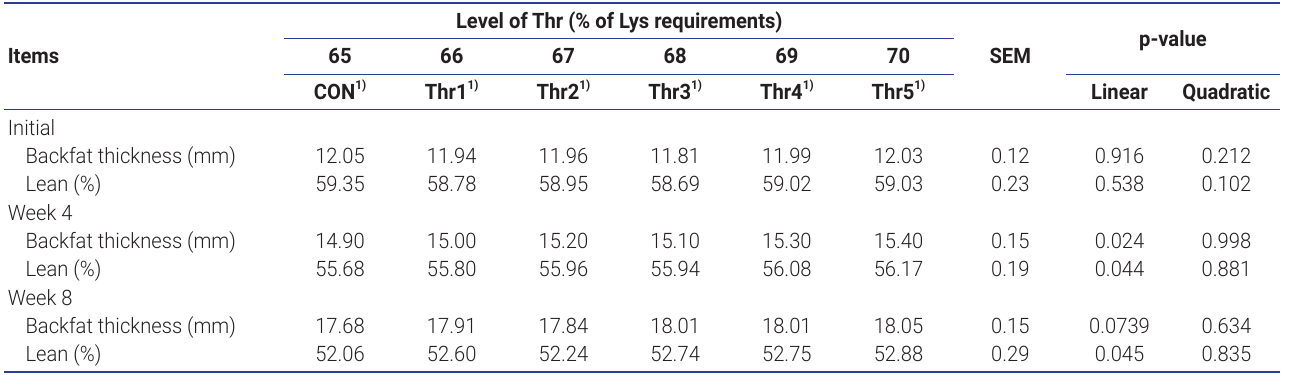
Level of Thr (% of Lys